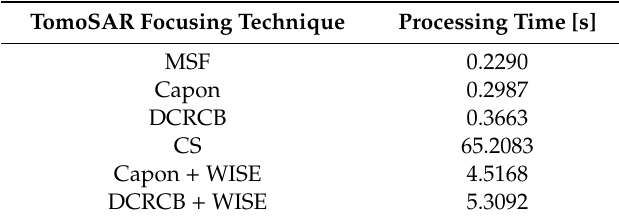
Table 2. Average Processing Time 1